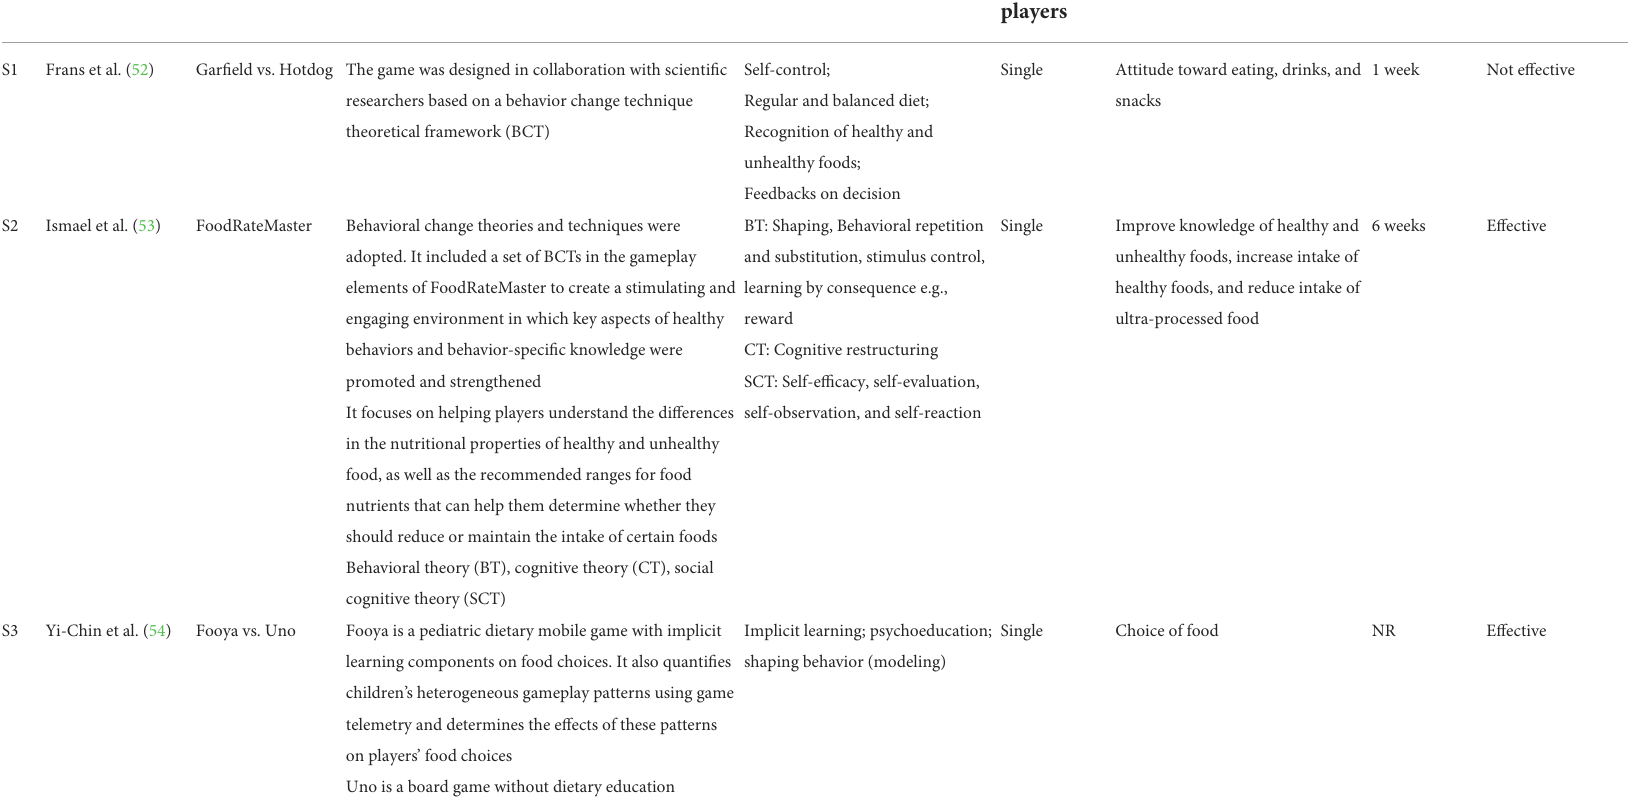
TABLE 1 Evidence